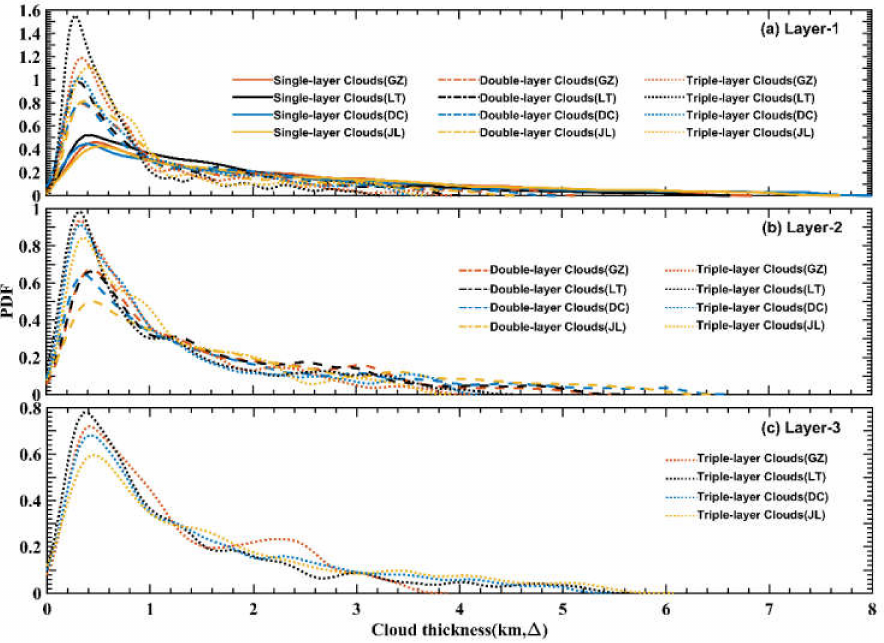
Figure 9. PDF plots of the thickness of single-layer, double-layer, and triple-layer clouds. ( a ) Layer-1; ( b ) Layer-2; ( c )